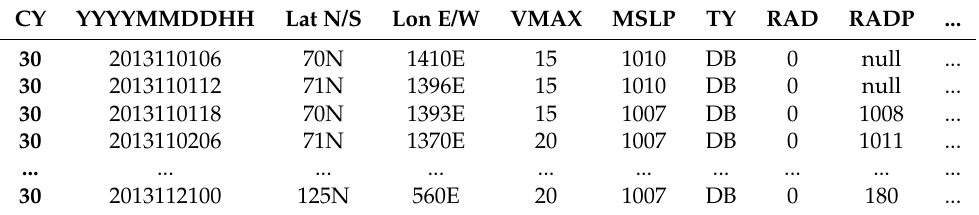
Table 2. Data representation of typhoon